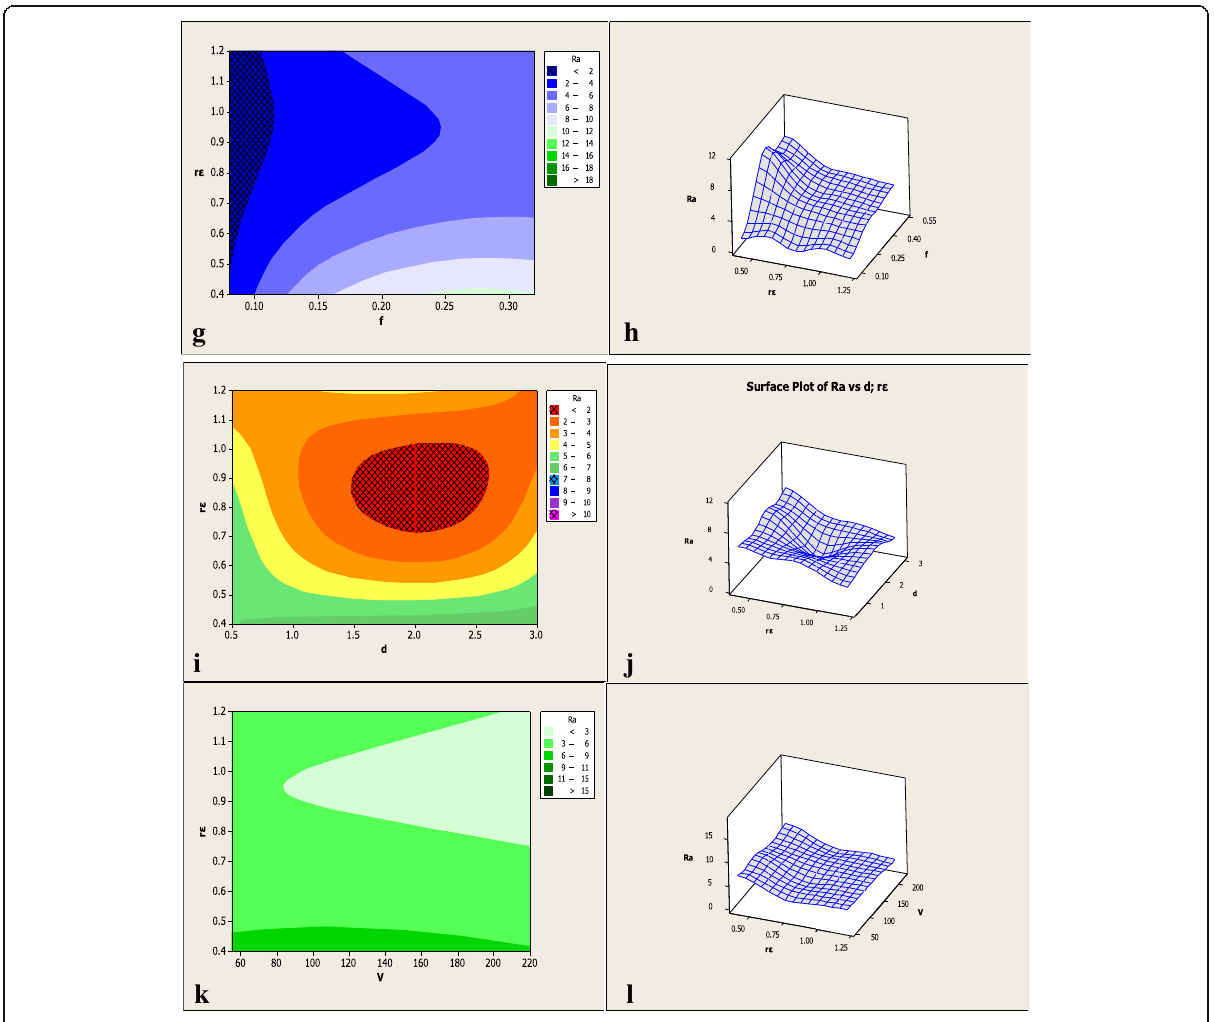
Fig. 9 Contour and 3D surface plots for the surface roughness ( R a )